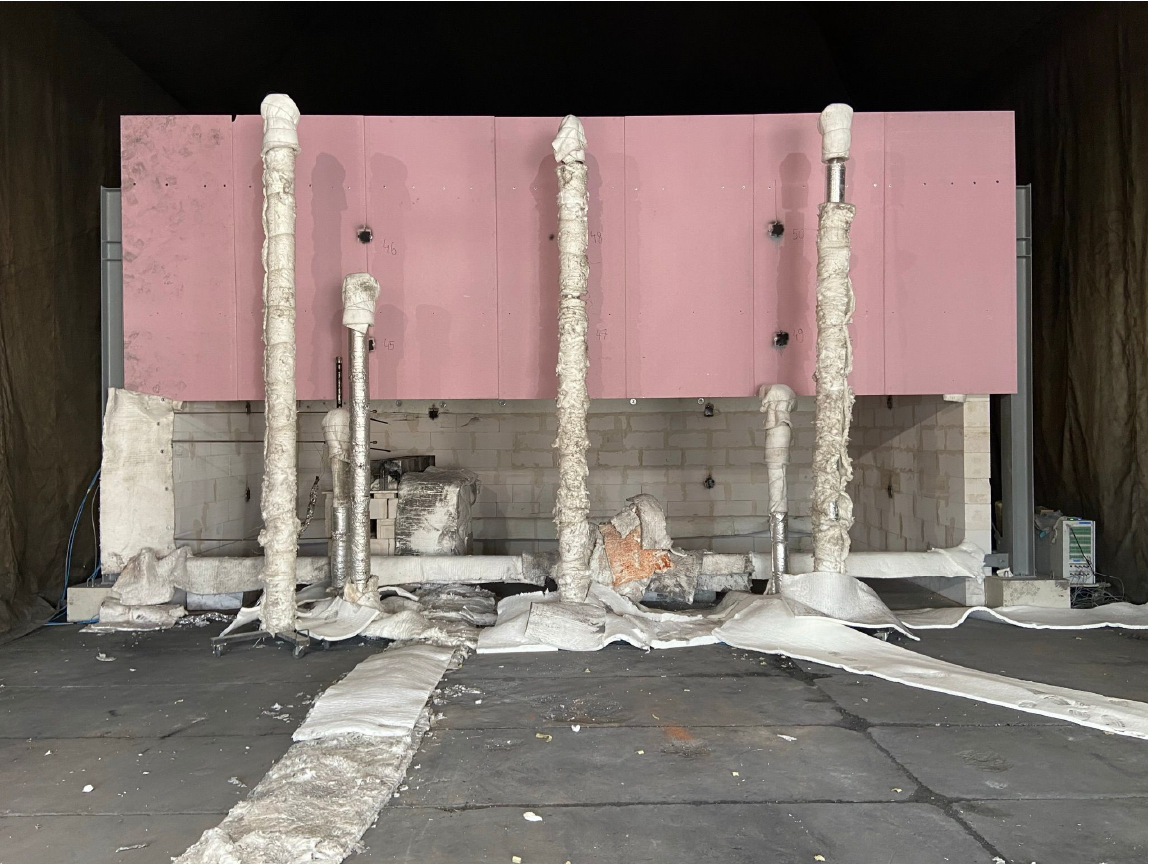
Figure 2. Image of enclosure before Experiment 1.